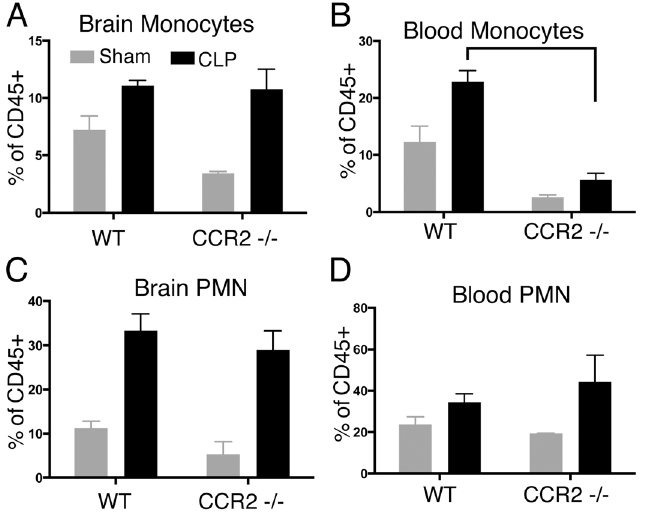
deficiency markedly decreases blood monocytosis (B). CCR2 deficiency has no effect on CNS (C) or blood (D) neutrophilia, as PMN do not express